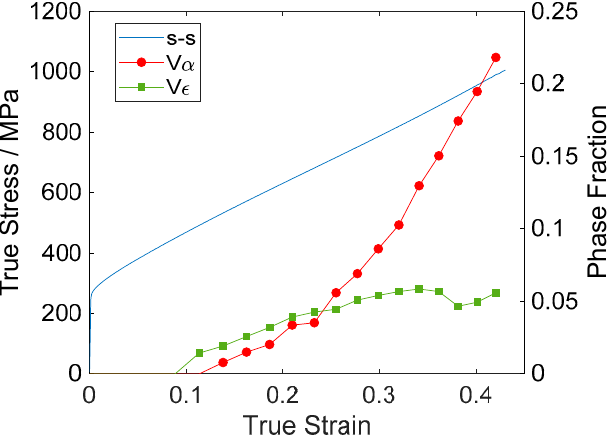
Figure 5. Change in volume fractions of α ’ (V α ) and ε (V ε ) martensite along with the true stress–true strain curve. The standard uncertainties were smaller than the markers (i.e., <1 × 10 − 3 ).